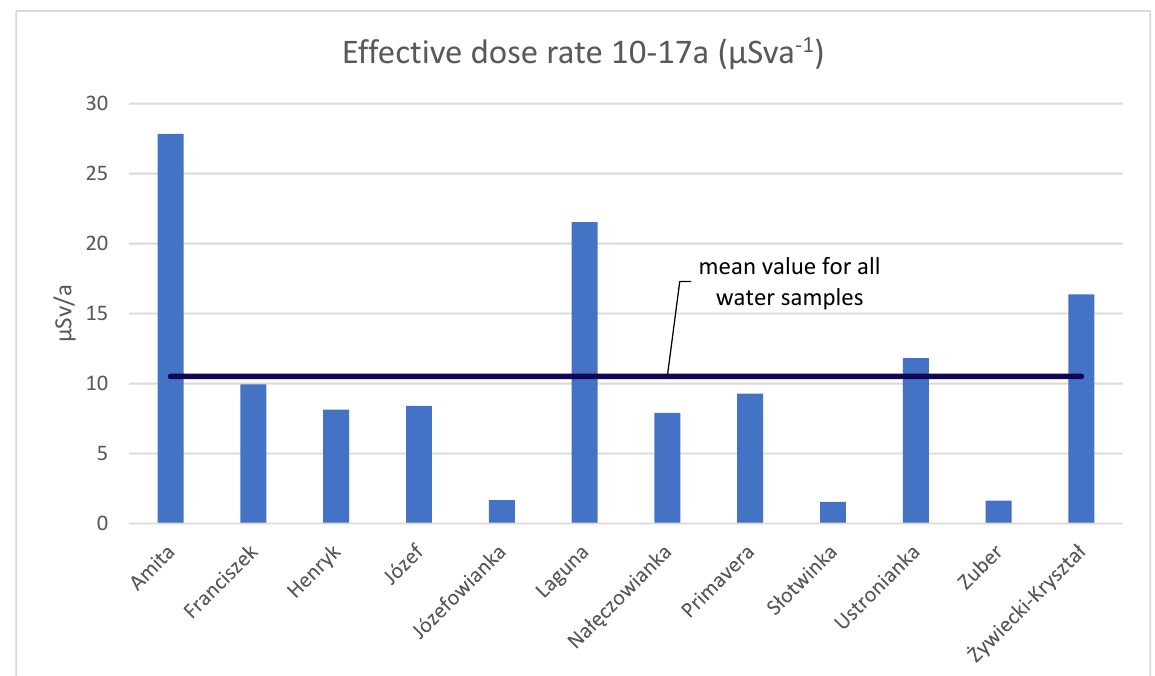
Figure 4. Annual effective dose for children from 1 to 10 years of age from the consumption of individual mineral waters.